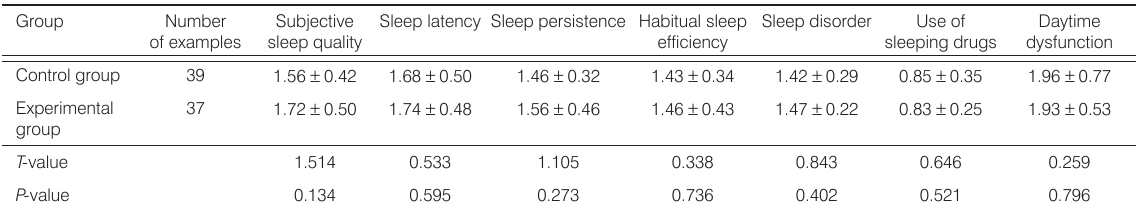
Table 2. Comparison of preoperative PSQI scores between the two groups.